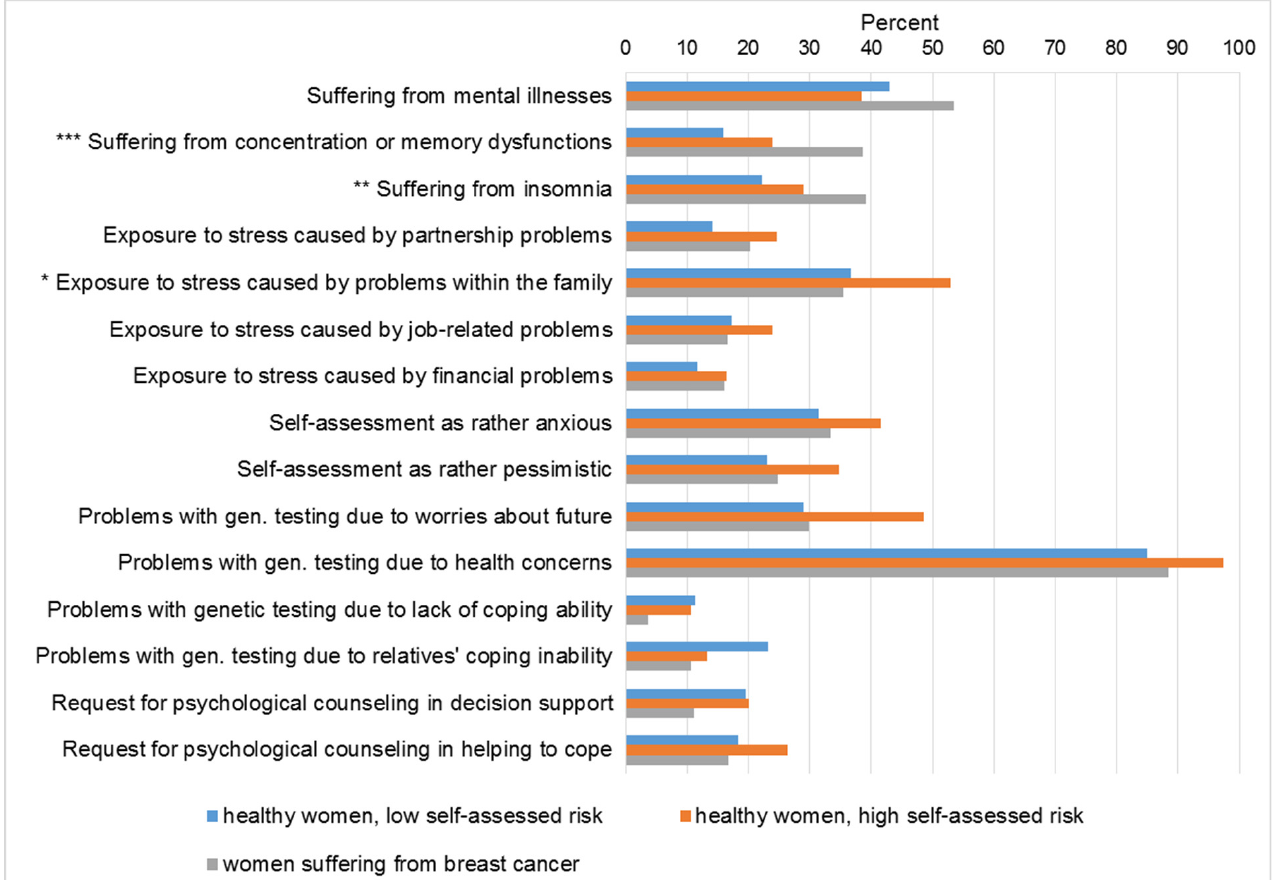
Figure 3. Psychological distress in women with suspected hereditary breast and ovarian cancer before genetic counseling. Total n = 416. Percentages are presented based on the respondents who answered the questions (valid answers ranging from 33–98%). Self-assessed risk 0–50: healthy women, low self-assessed risk; self-assessed risk 51–100: healthy women, high self-assessed risk. * p ≤ 0.05; ** p ≤ 0.01; *** p ≤ 0.001.